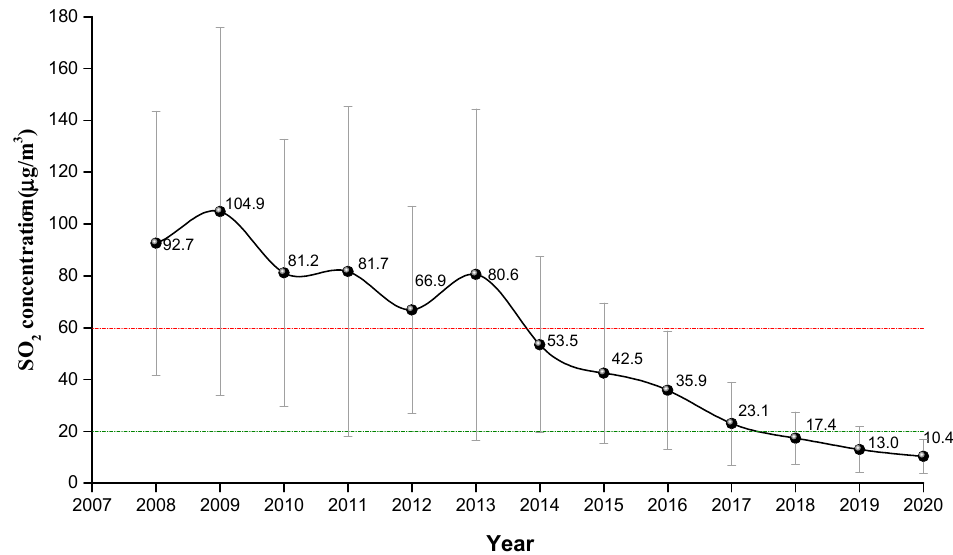
Figure 2. Annual average concentration of SO 2 from 2008 to 2020. (The bars indicate average value ± S.D. The analysis was performed based on 38 observations.)